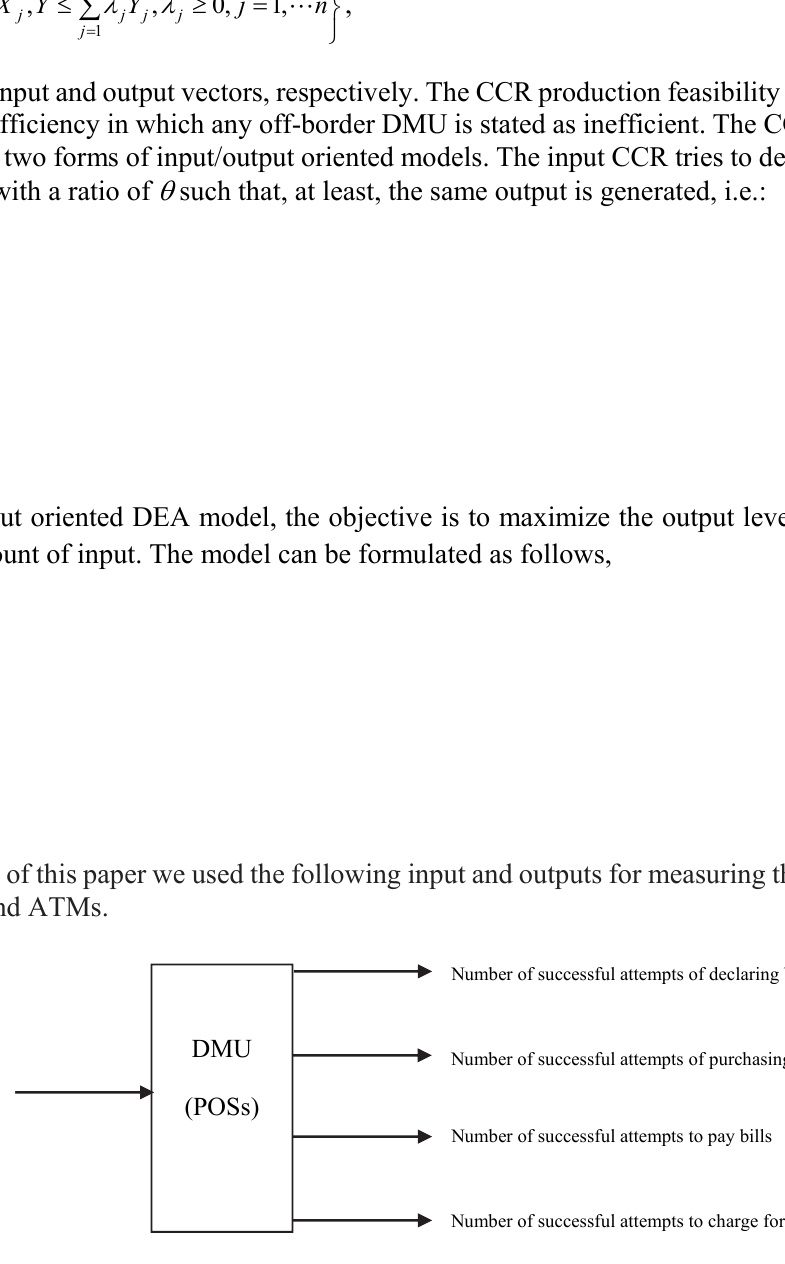
Fig. 1. The input and the output of DEA model for measuring the efficiency of POSs